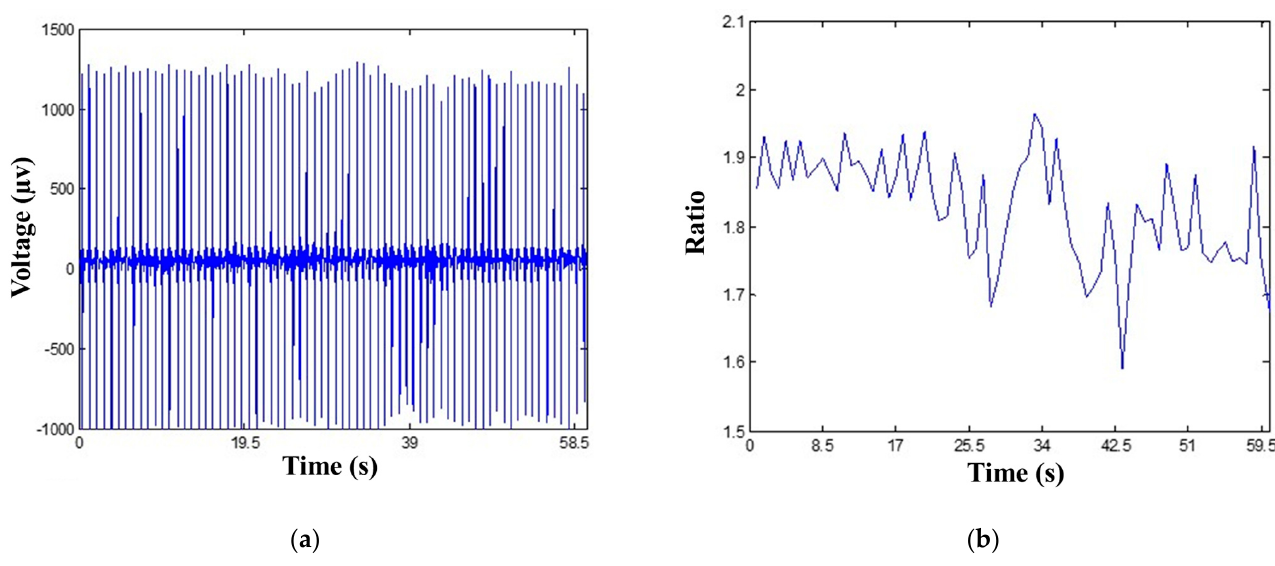
Figure 5. Approach of deriving respiration using the EDR algorithm. ( a ) R-peaks derived by the R-wave detection algorithm. ( b ) Respiratory movement of the thorax derived by the amplitudes of the R-peaks.